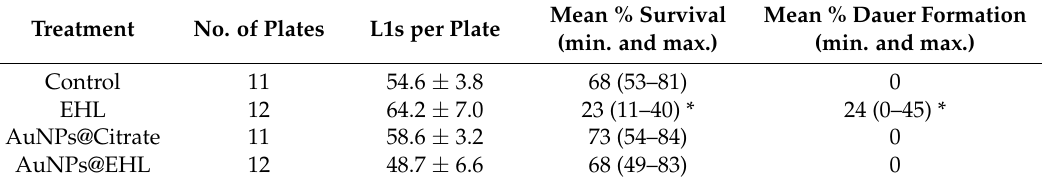
Table 2. EHL treatment affects survival and development of treated C. elegans L1s. When scored, adult worms were only observed on 3 of the 12 EHL plates, with worms showing varied degrees of developmental delay.